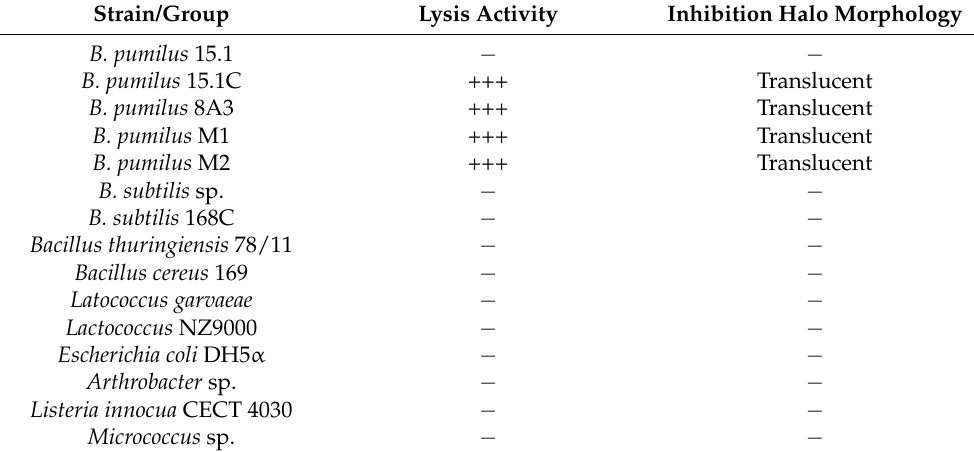
Table 7. Activity of Bp15.1PLP on bacterial strains from a laboratory